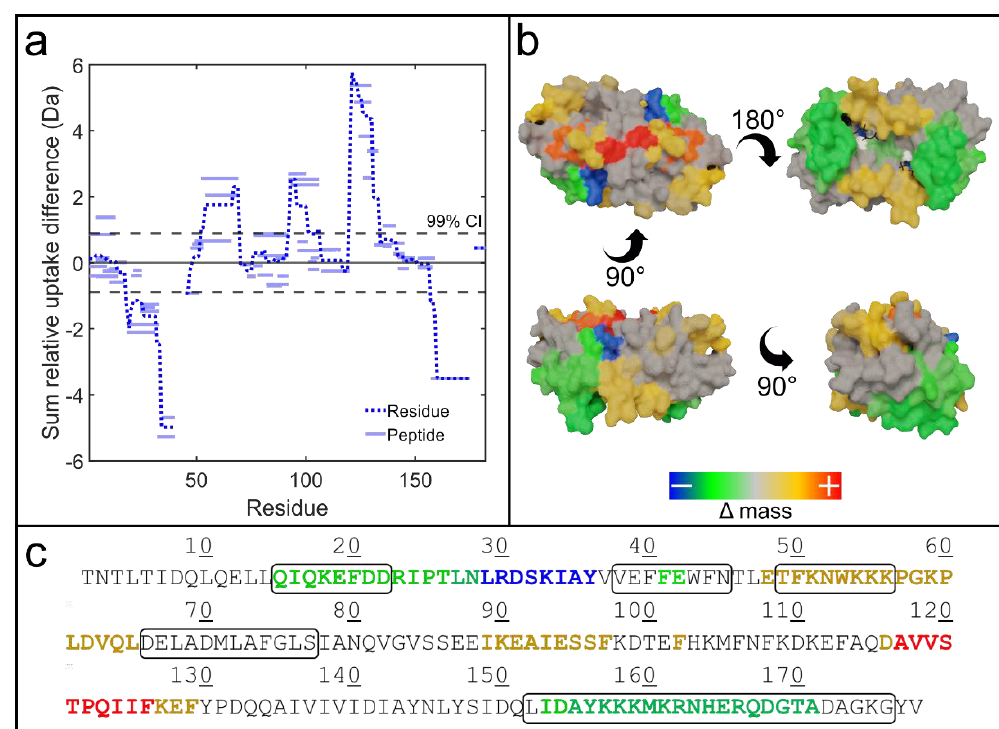
Figure 4. HDX-MS results for DUT ϕ NM1 upon mixing with Stl. ( a ) HDX di ff erence plot showing the Δmass of each peptide (solid lines) as well as the average amount per residue (dotted line). The dashed lines represent the 99% confidence bands evaluated over the whole dataset. ( b ) Homology model of DUT ϕ NM1 colored according to HDX-MS di ff erence data following the color gradient shown at the bottom of the panel; substrate analogue dUPNPP is also shown as black sticks in order to ease the visualization of the active sites (views: top, bottom, sides). Regions which could not be probed by HDX-MS are shown in white. ( c ) Sequence of the DUT ϕ NM1 protein. Conserved active site building motifs are boxed, letter coloring is according to HDX difference data.